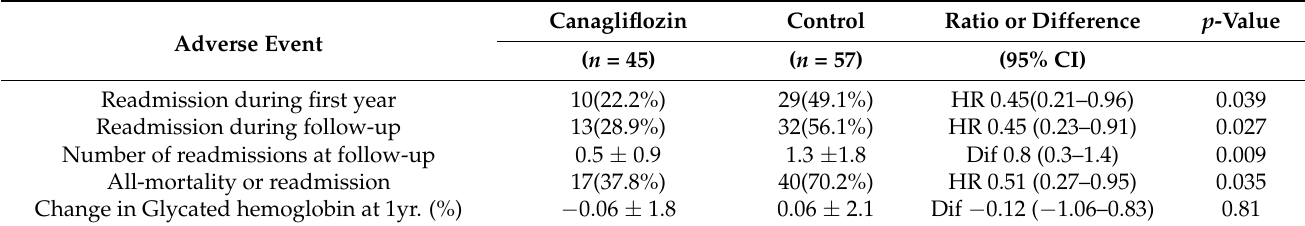
Table 2. Adverse events according to Canagliflozin treatment.